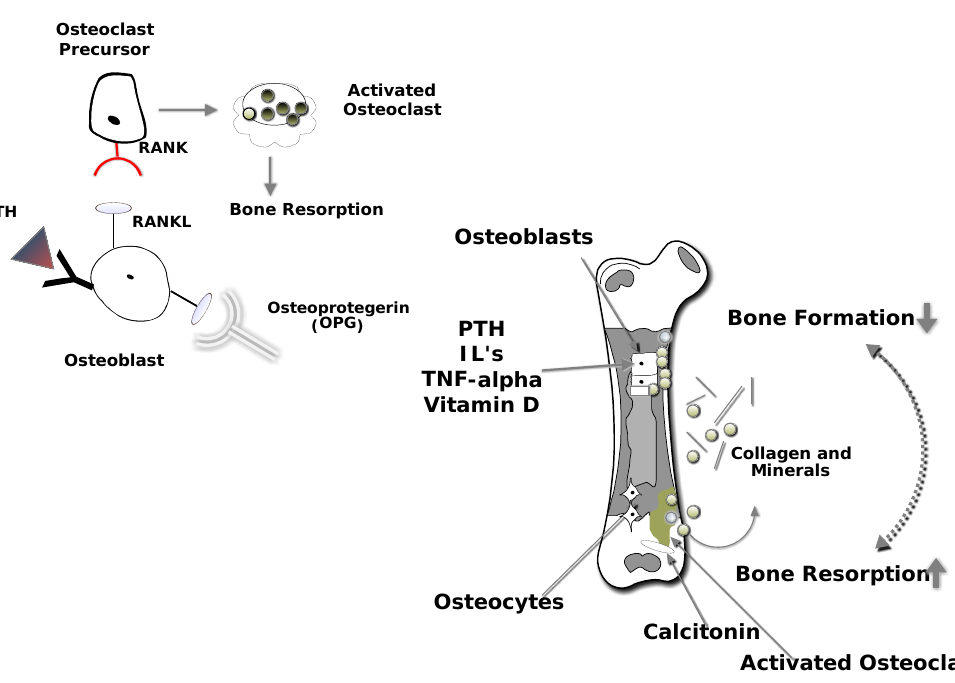
Figure 3. Bone Remodeling. As PTH levels rise, osteoblasts up-regulate the expression of RANKL, which binds to RANK, activating signaling pathways that promote osteoclast differentiation. Osteoblasts secrete osteoprotegerin which protects bone from resorption. Osteoprotegerin binds to RANKL and prevents binding to RANK, therefore the rate stimulation of osteoclastogenesis is reduced. PTH: parathyroid hormone; RANK: receptor activator of nuclear factor-κB; RANKL: receptor activator of nuclear factor-κB